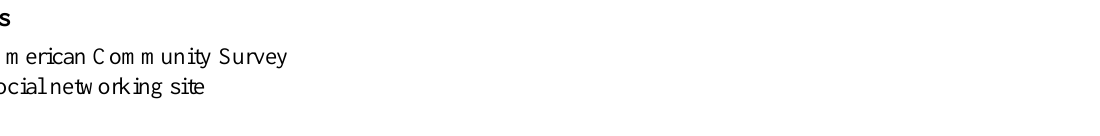
ACS: American Community Survey SNS: social networking